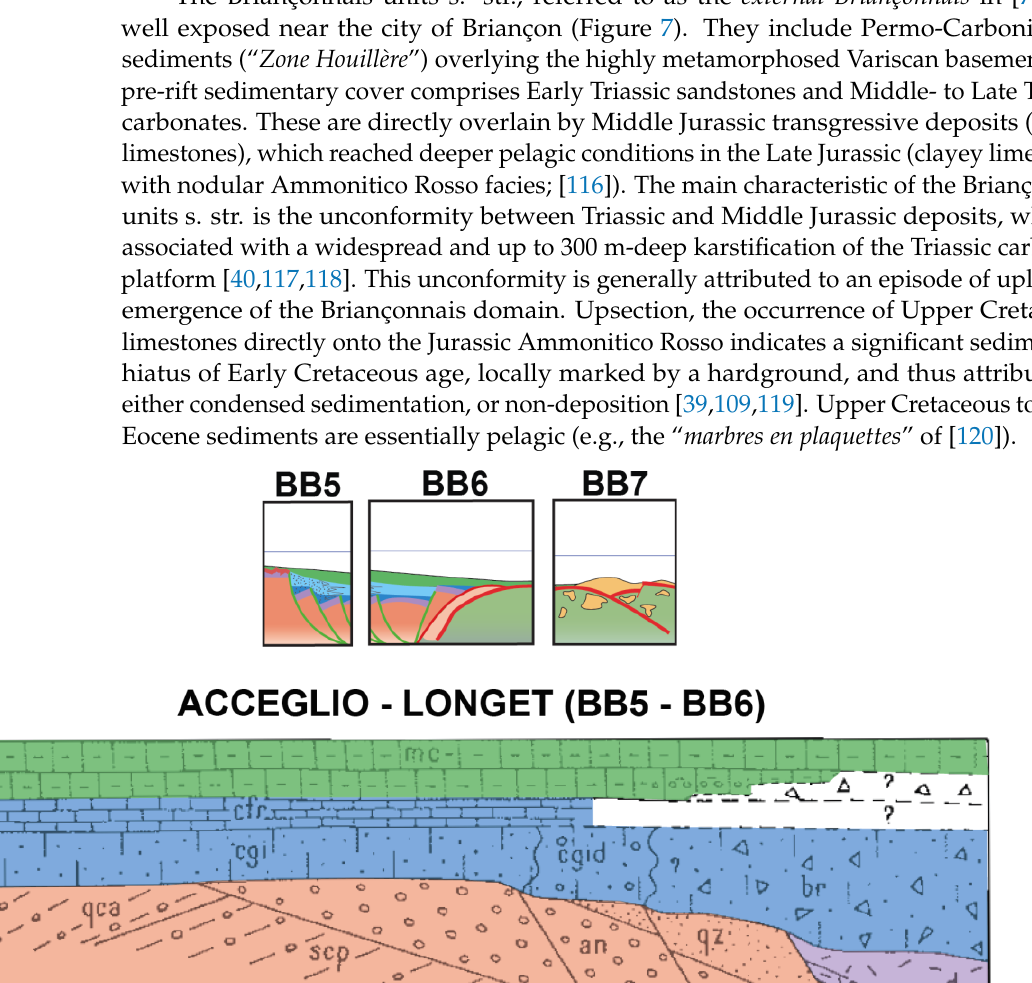
Figure 7. Examples of BB5, BB6 and BB7 in the Western Alps: ( a ) The Acceglio and Col du Longet outcrops display Jurassic sediments directly over basement and/or mega-breccia bodies, which are here interpreted as characteristic of a distal margin (BB5 and/or BB6); Figure modified from [121] see text for details and discussion); ( b ) The Tasna Nappe is consensually recognized as preserving an ocean – continent transition (OCT) between thinned continental crust and exhumed mantle, and thus was regarded as a BB6 by [19]. The Chenaillet ophiolite displays remnants of an embryonic seafloor spreading system, and thus was regarded as a BB7 by [19]. Figure modified from [100]. Ref. [19] attributed a BB3 affinity (cf. Figure 1) to the Briançonnais units s. str. Here we follow this hypothesis and additionally suggest that the Briançonnais s. str. formed a ribbon of moderately thinned crust between the overstepping en-échelon Valais and Pie- monte basins, which individualized during the Pliensbachian – Toarcian lithospheric neck- ing. The two basins eventually merged during crustal breakup, so that the Briançonnais ribbon was attached to the European margin in the southwest, while it was separated from the European margin by the V-shaped Valais Basin in the northeast (e.g., [122]; see Section 7.2.3 for discussion). Note that comparable rift architectures can be seen today along the